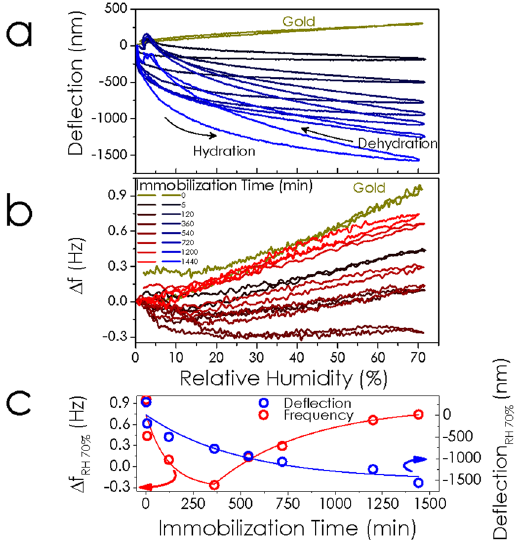
Figure 2. Hydration dependence of the static deflection and the fundamental resonance frequency of cantilevers for increasing packing density of the ssDNA SAM. ( a ) Cantilever static deflection variation during a hydration and dehydration cycle for a representative gold-coated silicon cantilever sensitized with thiol- modified 20-mer ssDNA molecules. For comparison, the hydration/dehydration loop for the gold-coated cantilever before functionalization is also shown (dark yellow line). The static deflection variations are measured with respect to the rest position at a relative humidity of 0%. ( b ) Cantilever fundamental resonance frequency variations as a function of the relative humidity for increasing incubation times ranging from 5 min up to 24 h. For comparison, we show the hydration/dehydration loop for the gold-coated cantilever before immobilization. Measurements were acquired simultaneously to those in ( a ) for each cantilever at every given incubation time. The resonance was measured by a homemade detection system, see Supplementary Information. ( c ) Values of the deflection (blue symbols) and the frequency shift (red symbols) at RH 70% as a function of the immobilization